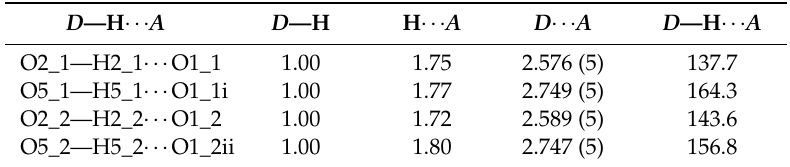
Table 2. Hydrogen-bond geometry (Å, ° ).